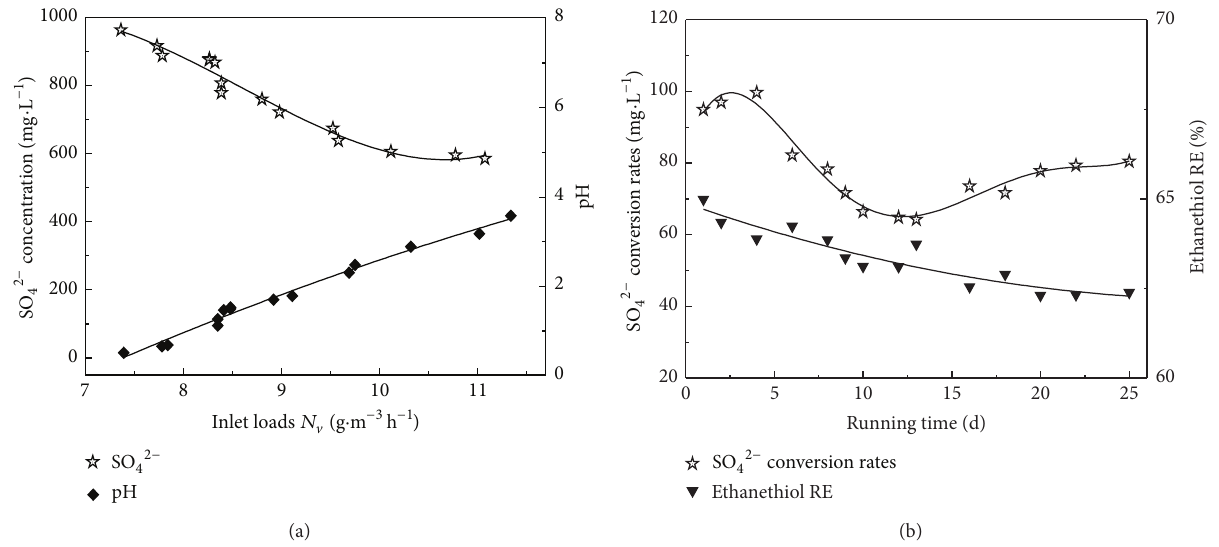
Figure 7: (a) The effects of ethanethiol inlet loads on sulfate ion concentration and pH and (b) continuous operation SO 42− conversion rate and ethyl mercaptan removal rate.